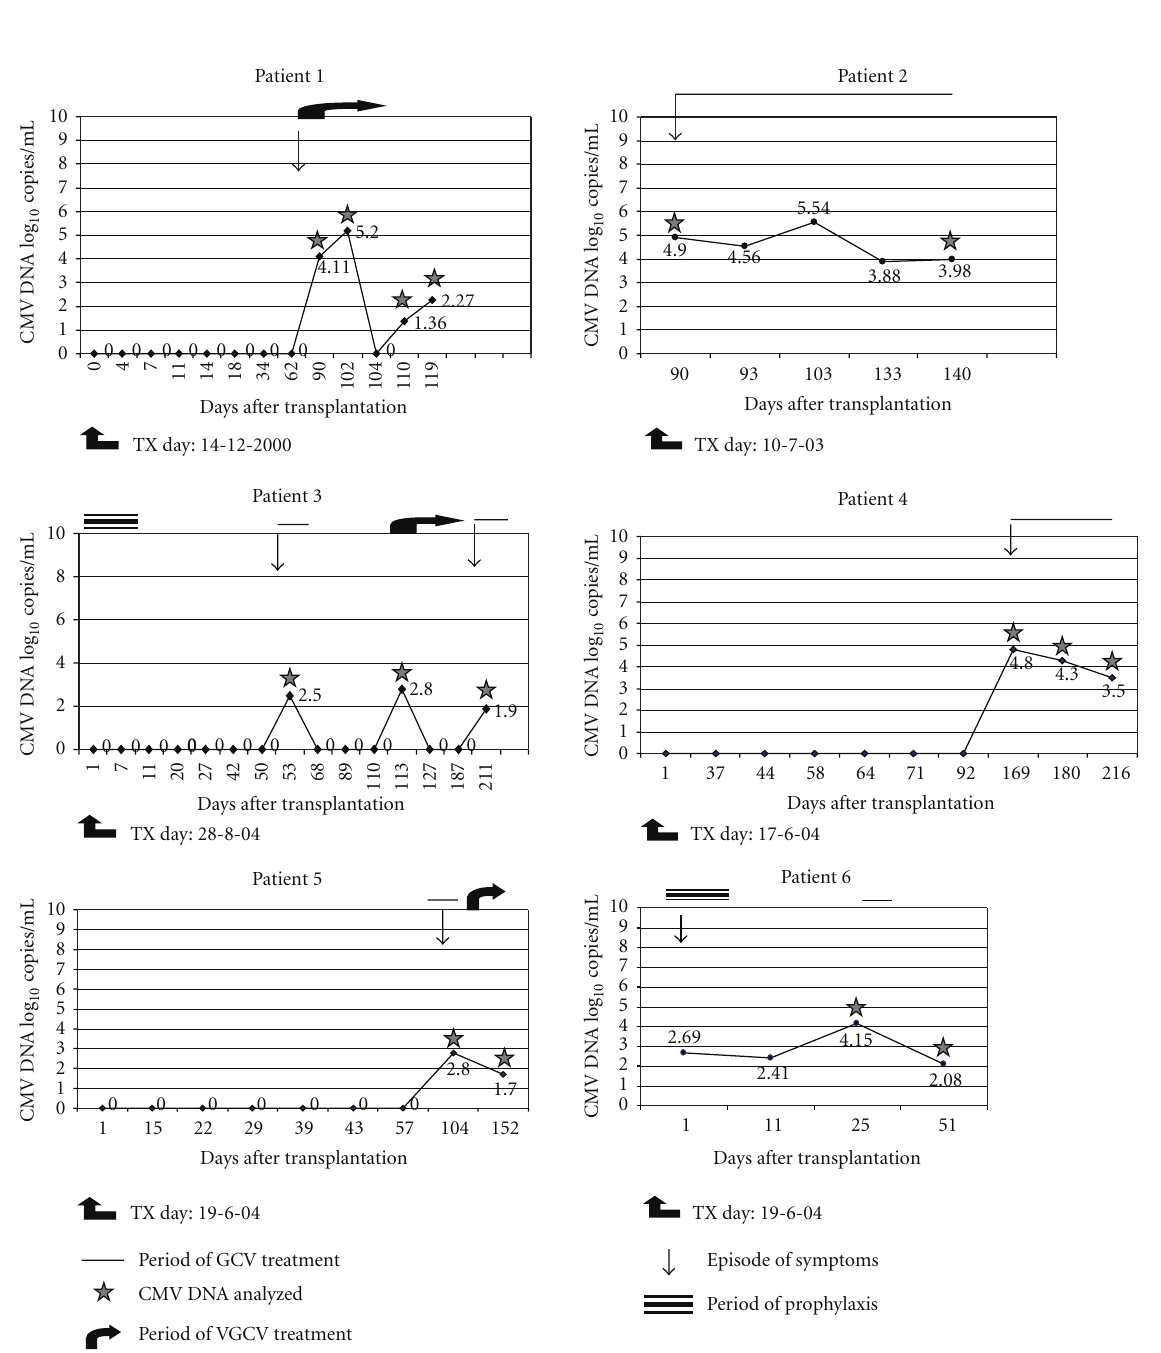
Figure 1: Monitoring of the viral load in kidney transplant